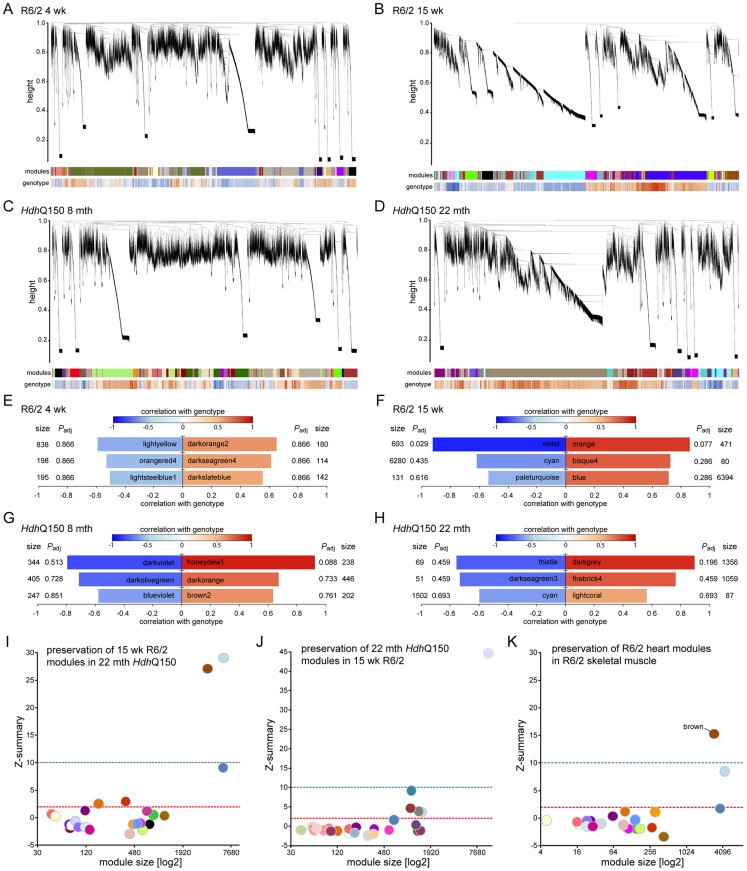
WGCNA analysis of heart RNAseq data.(A–D) Hierarchical cluster trees of the average linkage in the dissimilarity topological overlap matrices. Each vertical line correlates to a gene. The height is a measure for the dissimilarity based on the topological overlap. The first band under the dendrogram is a visual representation of the identified modules. The second band indicates the correlation with genotype based on the gene significance for each gene. Red is positively correlated with genotype, blue is negatively correlated. (A) Hierarchical cluster tree for WT versus R6/2 at 4 weeks of age. (B) Hierarchical cluster tree for WT versus R6/2 at 15 weeks of age. (C) Hierarchical cluster tree for WT versus HdhQ150 at 8 months of age. (D) Hierarchical cluster tree for WT versus HdhQ150 at 22 months of age. (E–H) Modules that were highly correlated with genotype in the respective networks are shown and are ranked according to their correlation with genotype. Size is the number of genes for each module. Padj gives the Benjamini Hochberg corrected significance value for each module. (E) Modules in the R6/2 network at 4 weeks of age. (F) Modules in the R6/2 network at 15 weeks of age. (G) Modules in the HdhQ150 network at 8 months of age. (H) Modules in the HdhQ150 network at 22 months of age. (I–K) Preservation analysis of late stage R6/2 and HdhQ150 networks. The Z-summary is a measure for module preservation. Values less than 2 (red lines) indicate no preservation, between 2 and 10 (blue lines), module structures are preserved and above 10 the module structure is highly preserved. (I) Preservation of R6/2 modules at 15 weeks in the HdhQ150 network at 22 months. (J) Preservation of HdhQ150 modules at 22 months in the R6/2 network at 15 weeks. (K) Preservation of R6/2 modules at 15 weeks in a R6/2 network of skeletal muscle at 12 weeks.